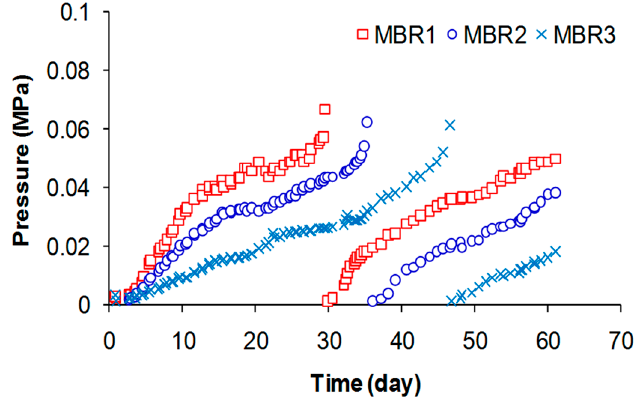
Figure 5. Transmembrane pressure profiles and cleaning.